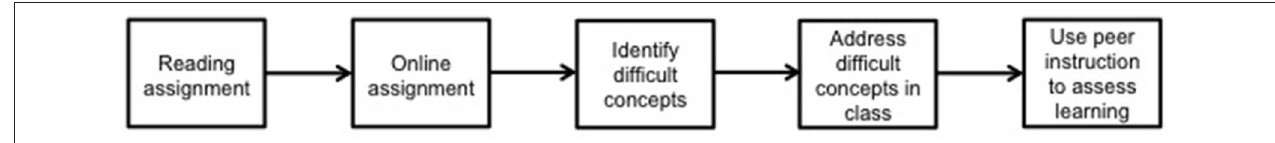
FIGURE 3 | Sequence of events involved in just-in-time teaching.